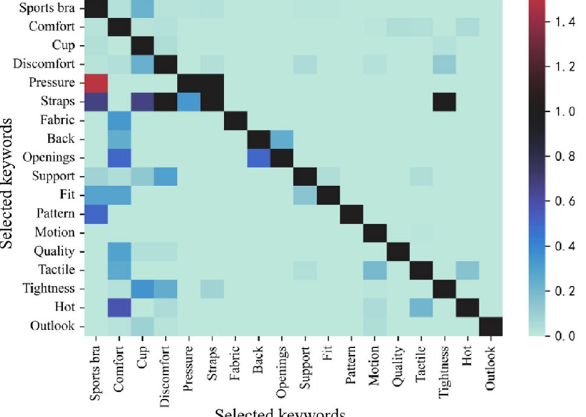
Fig. 4 Heatmap of the correlation coefficient among keywords. Comparison of strength values among keywords. Keyword pairs with stronger relationship were represented as darker color as the right contour bar